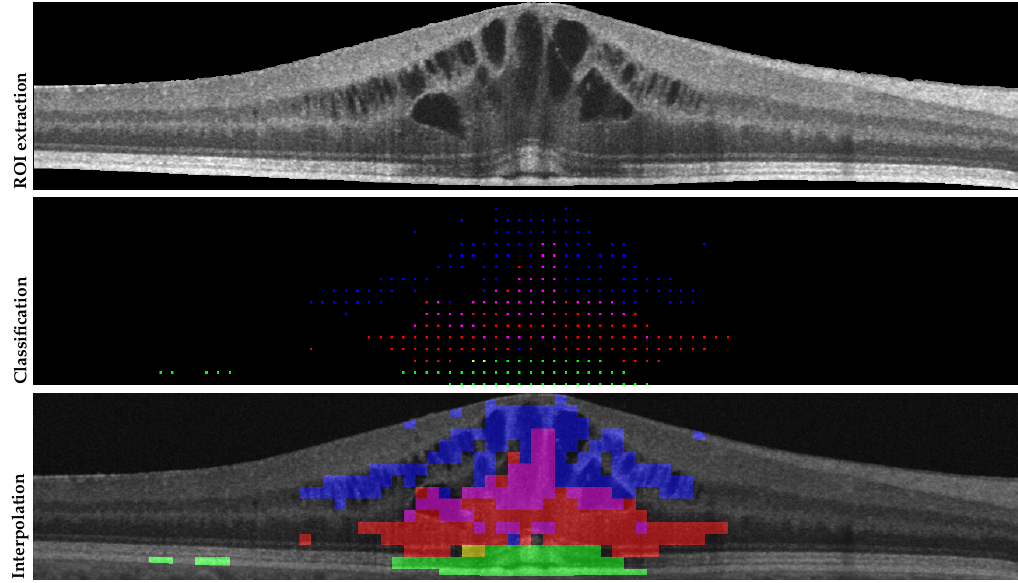
Figure 8. Steps to generate the binary maps. An overlap of 45px was used between